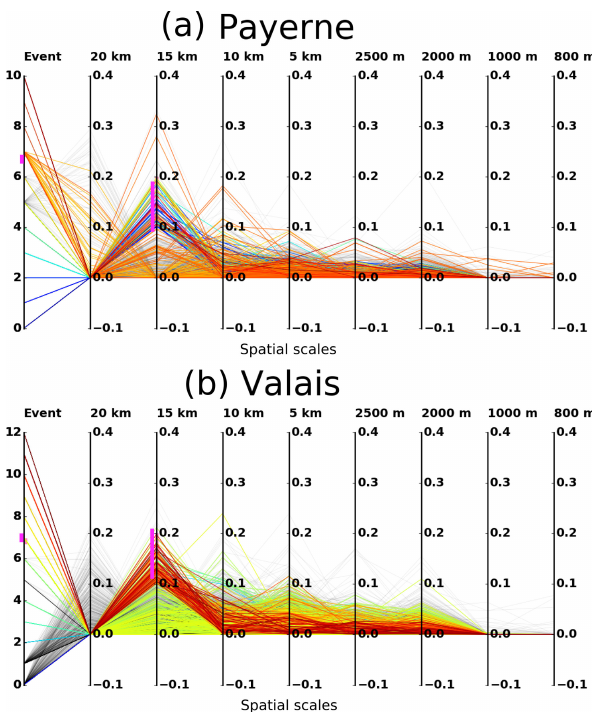
Figure 11. Parallel coordinate plots illustrating the intra- and inter- event variability of the fractions of variance explained by compo- nents of the melting layer tops, for the MXPol in Payerne (a) and the MXPol in the Valais (b) , highlighted for a single event (number 7, indicated in pink on the first y axis, and event lines are orange for Payerne and yellow for Valais) and highlighted for 10% of the explained variance for the second component (indicated in pink on the third y